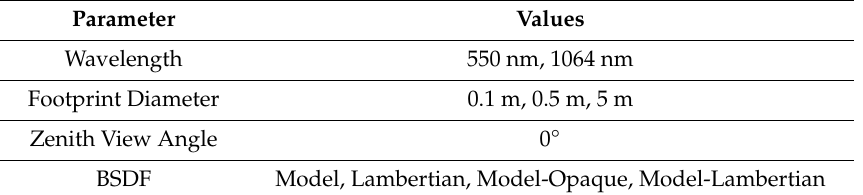
Table 6. List of parameters and associated values for simulations of the maple and oak grove